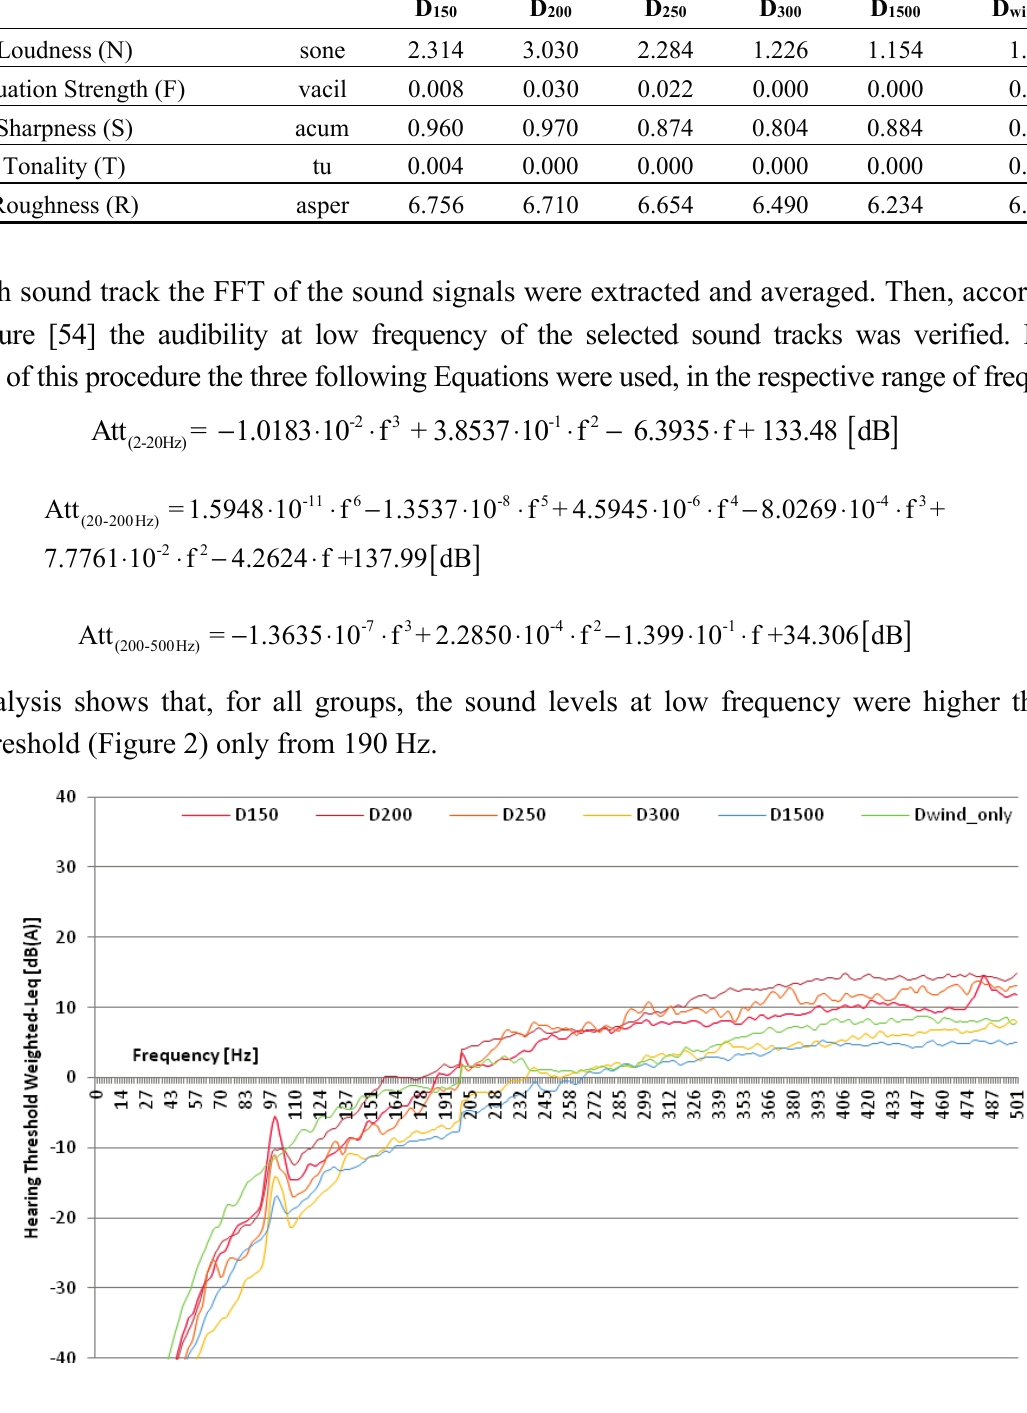
Figure 2. FFT of the hearing threshold weighted-Leq for the sound tracks groups D 150 , D 200 , D 250 , D 300 , D 1500 and D wind_only